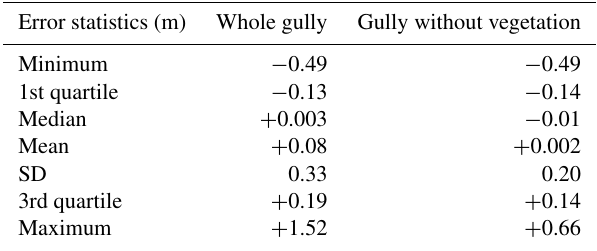
Table 5. Error statistics at the scale of the gully shown in Fig. 10. Error statistics (m) Whole gully Gully without vegetation Minimum − 0.49 − 0.49 1st quartile − 0.13 − 0.14 Median